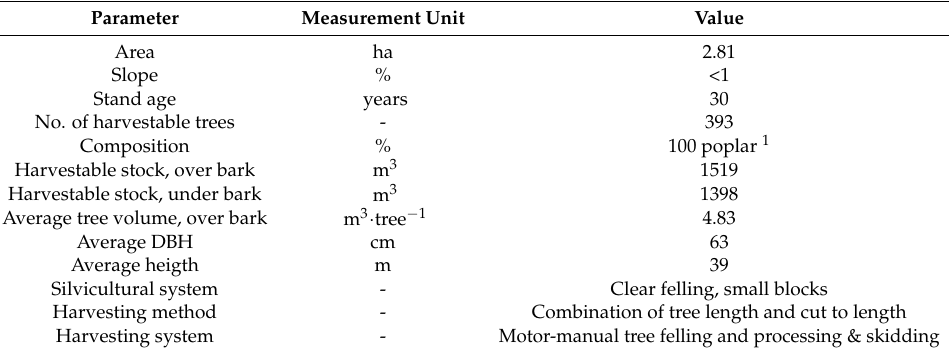
Figure 1. Study location. Table 1. Description of the felling block.